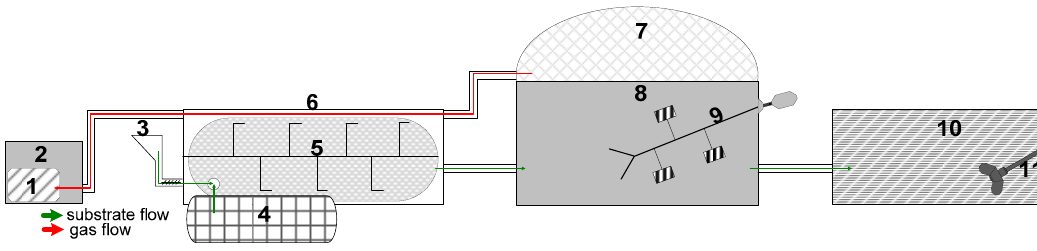
Figure 1. “Functional elements” of the investigated biogas plant. 1: CHP; 2: Control room; 3: solids fedders 4: Fermenter dump (slurry); 5: Agiator; 6: Fermenter; 7: Gas storage; 8: Secondary fermenter; 9: Paddle-giant; 10: Final storage; 11: Agiator.